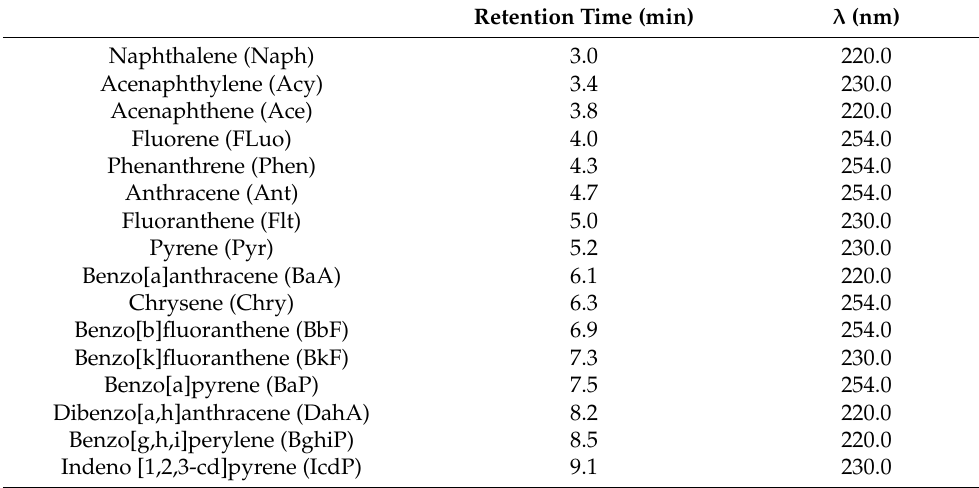
Table 1. Retention time and the UV wavelength ( λ ) at which the peak of each PAH is most